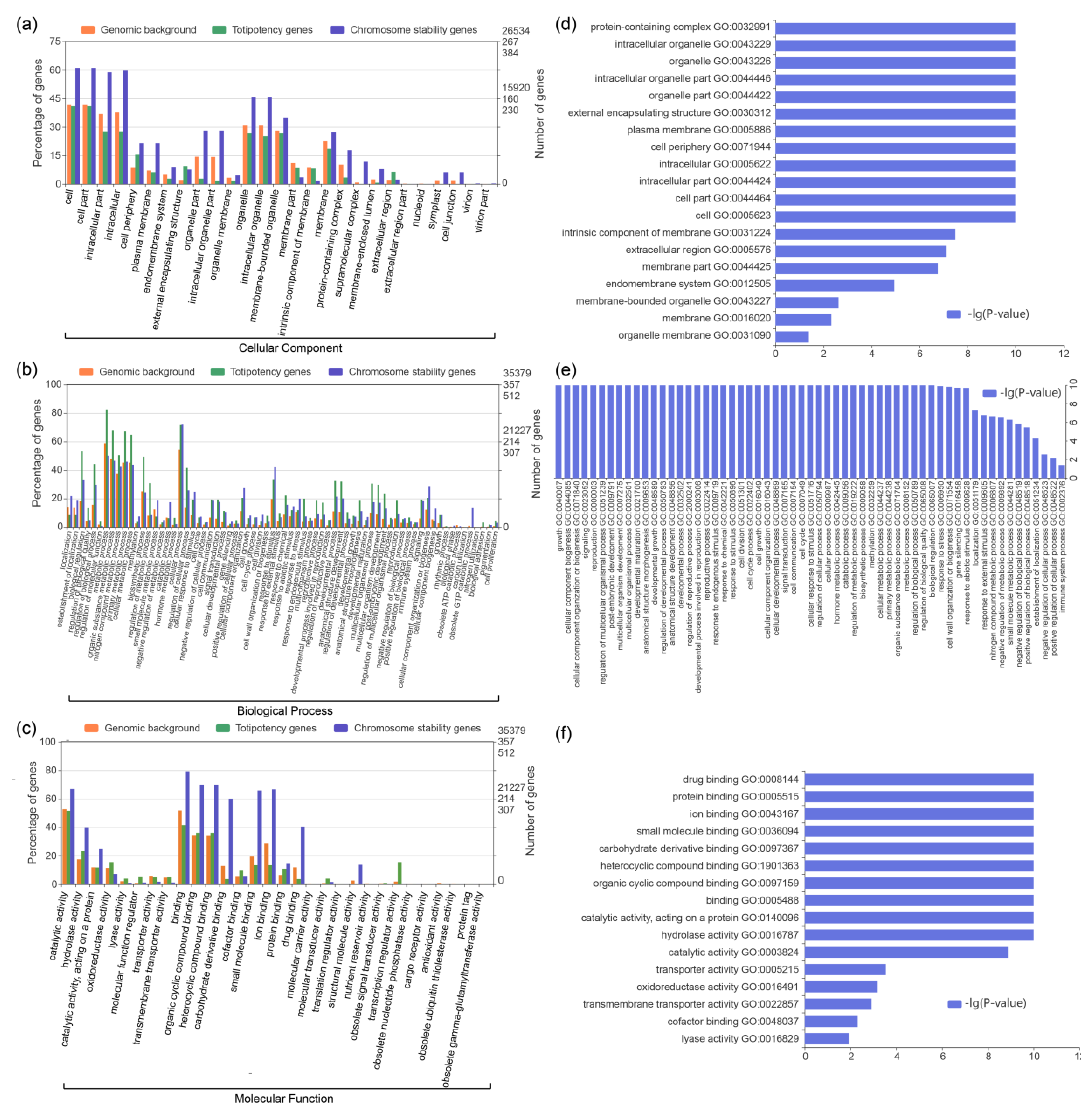
Figure 3. GO enrichment analysis of the total totipotency and chromosome stability-related genes. Enriched GO terms in cellular component ( a , d ), biological process ( b , e ) and molecular function of the total genes ( c , f ), totipotency genes and chromosome stability